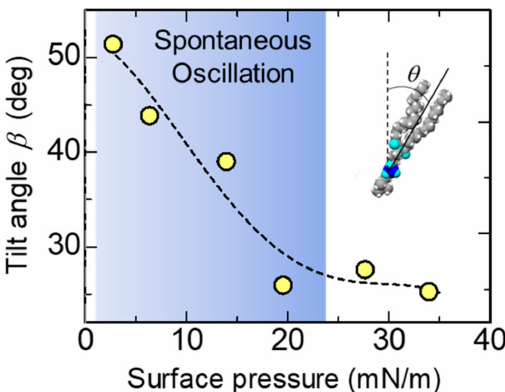
Figure 7. Dependence of the tilt angle of the hydrophobic chains on the surface pressure of the DSPC. The region of the spontaneous oscillation of surface tension shown in blue. The dashed curve is a guide to the